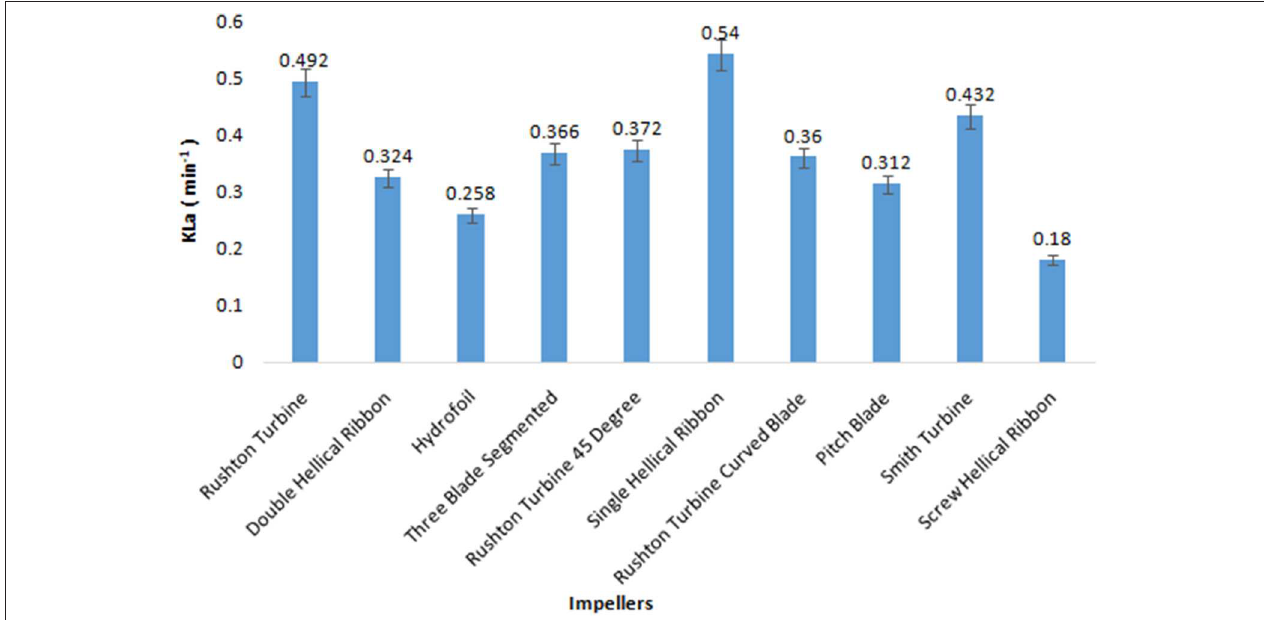
FIGURE 1 | Volumetric mass transfer coefficient (K L a) values for various